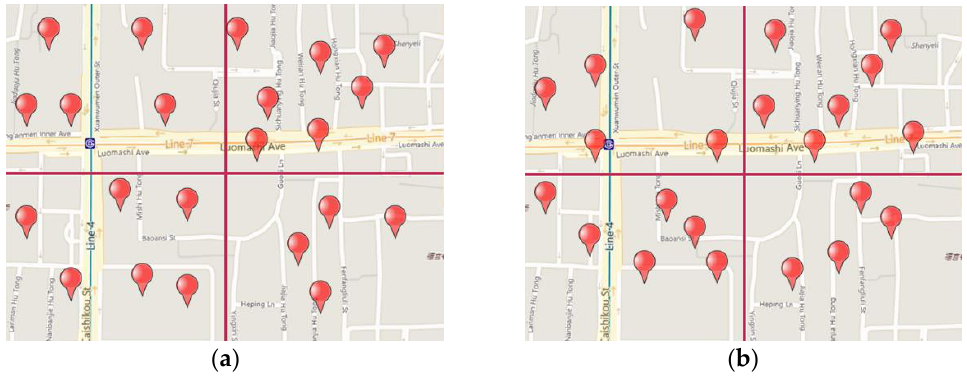
Figure 4. The local position maps of EVs. ( a ) before noise addition; ( b ) after noise addition.